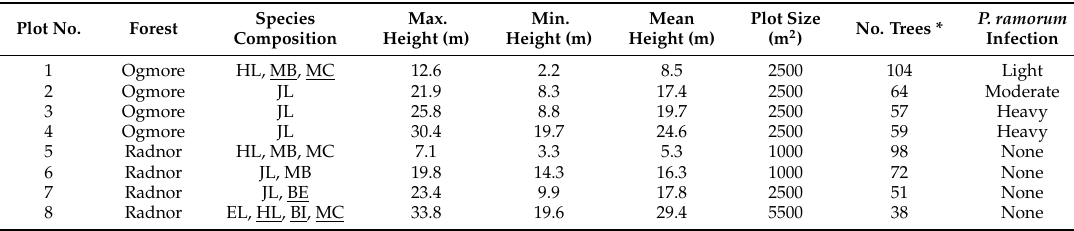
Table 1. Sample plot